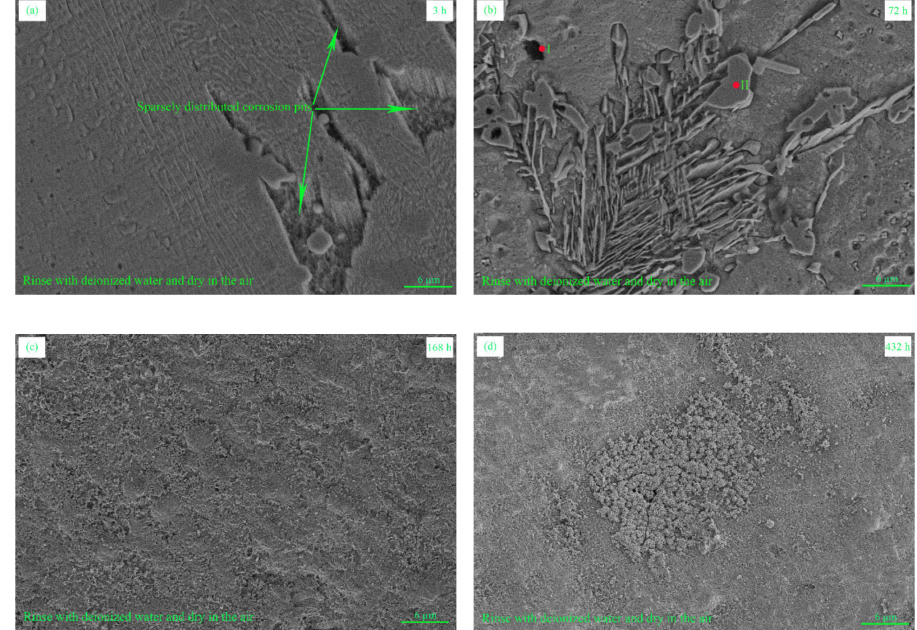
Figure 6. SEM images of DFS immersed in 3.5% NaCl solution at di ff erent times: ( a ) 3 h; ( b ) 72 h; ( c ) 168 h; ( d ) 432 h.